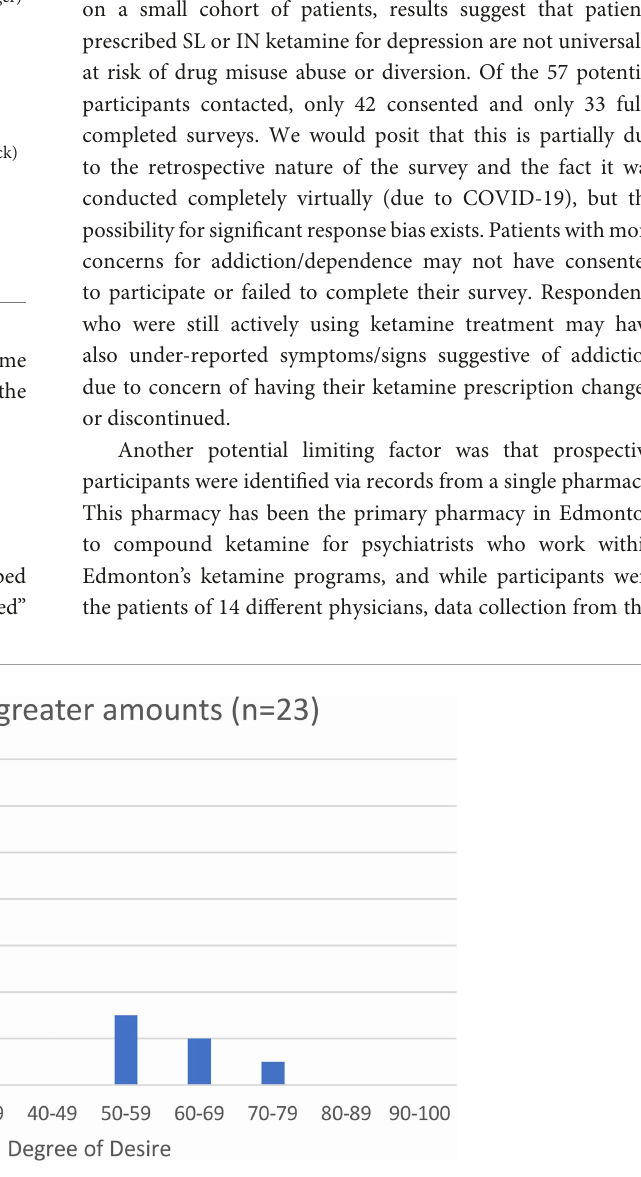
FIGURE3 Desire to use ketamine in amounts greater than